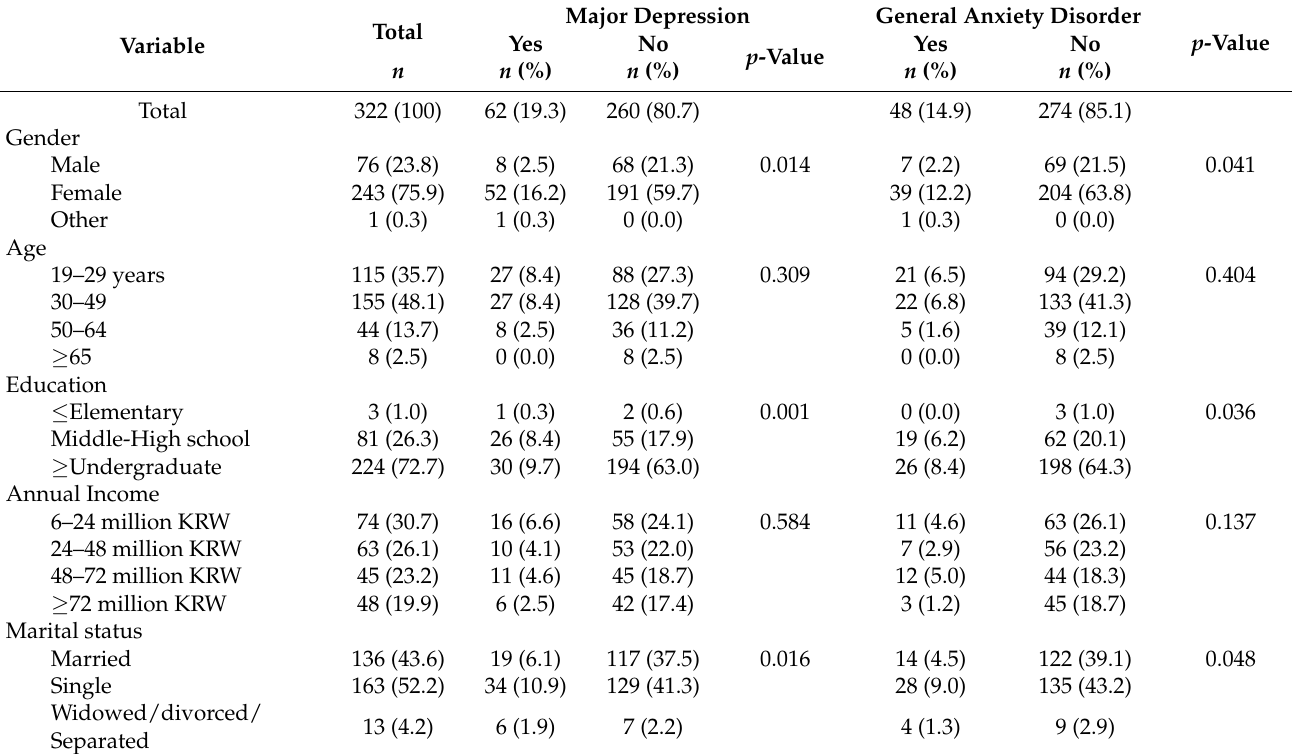
Table 1. Descriptive statistics of survey participants by frequency of probable Major Depression and Generalized Anxiety Disorder ( n =